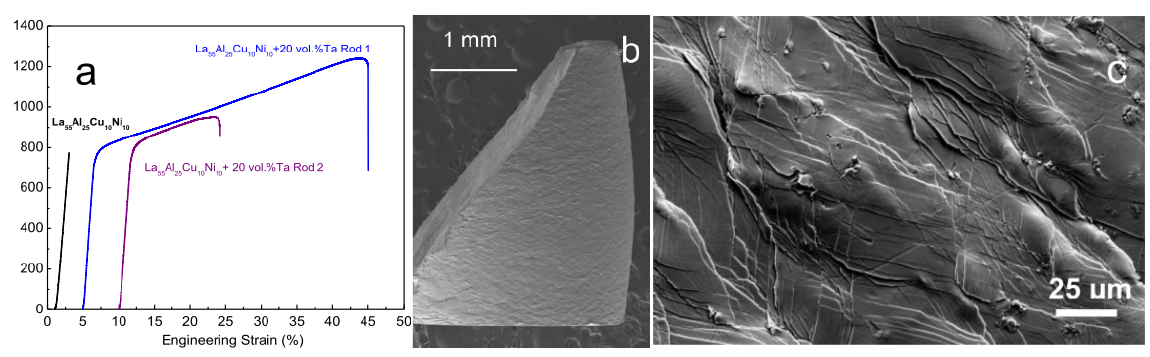
Al Cu Ni bulk 55 25 10 10